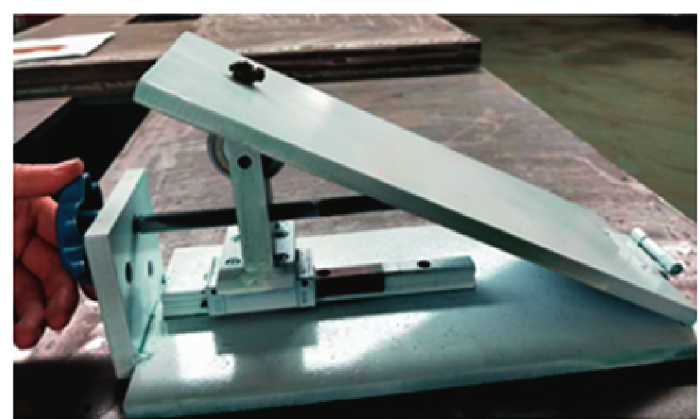
Figure 9: Rolling friction coefficient measuring